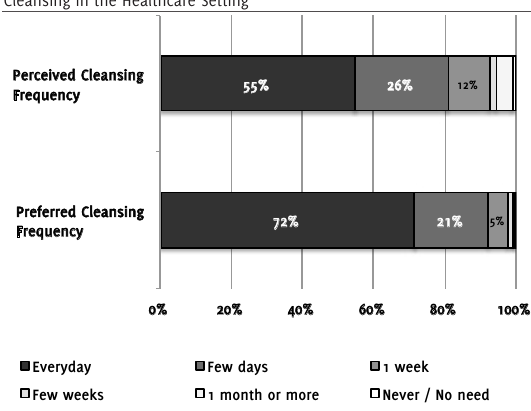
Note: Percentages from total patient population,